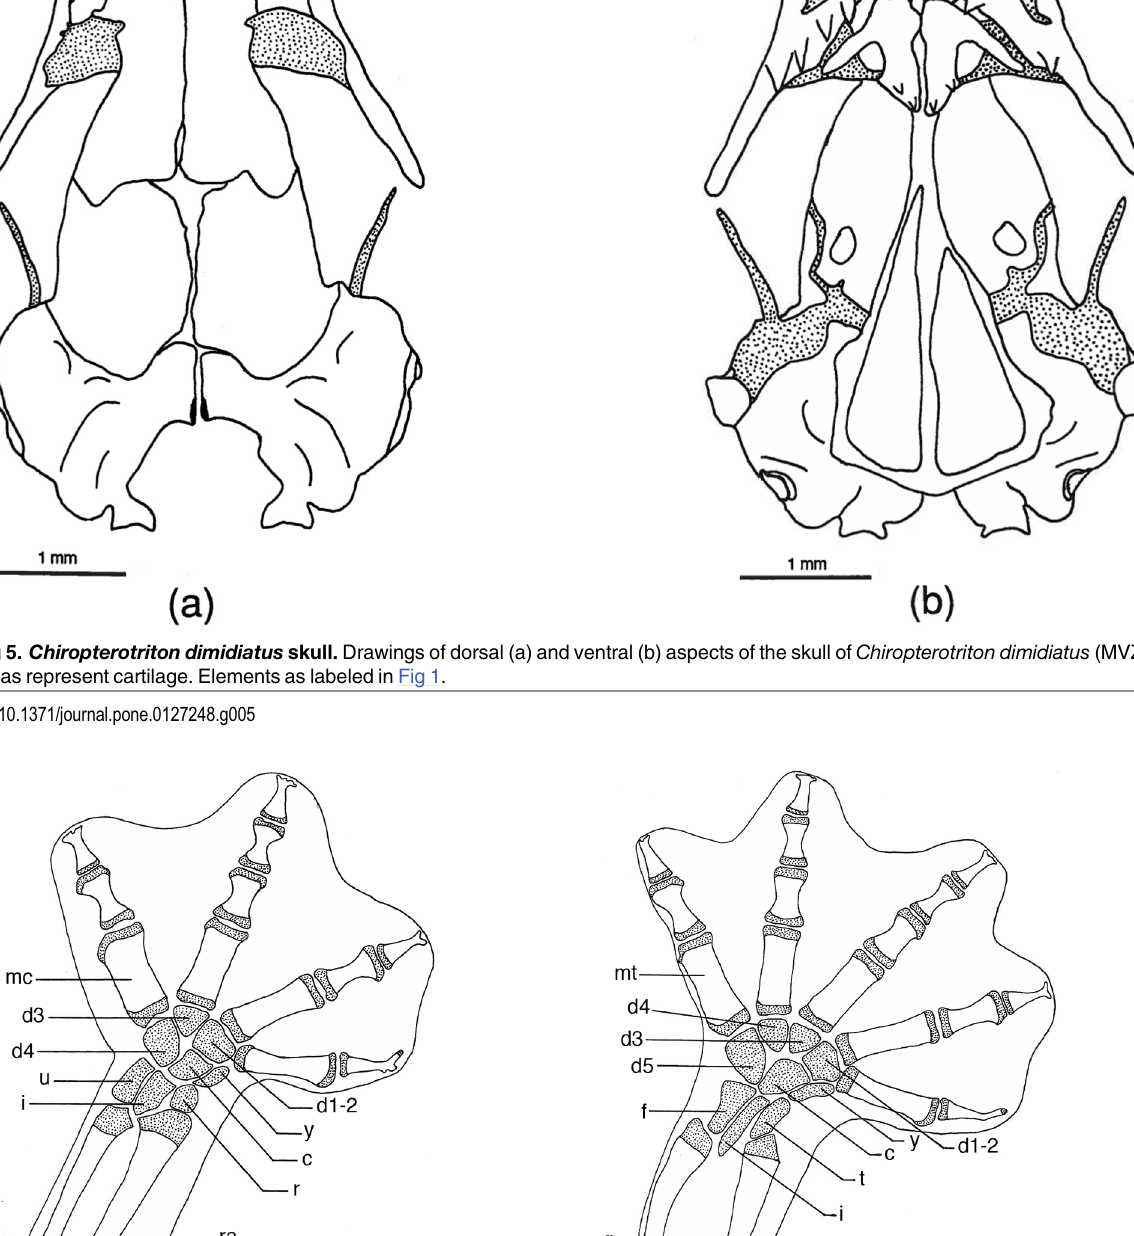
PLOS ONE | DOI:10.1371/journal.pone.0127248 June 10,